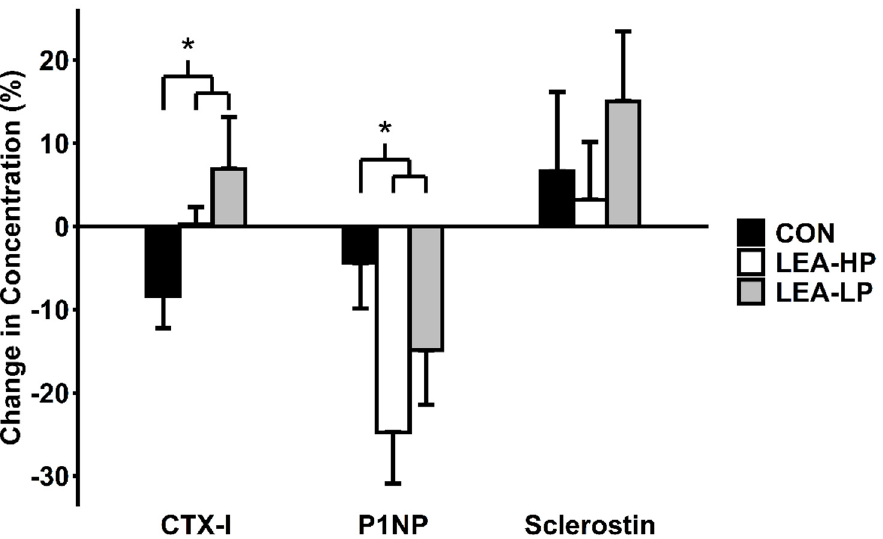
Figure 3. Changes in markers of bone turnover by condition. Abbreviations: CTX-I, type I collagen cross-linked C-telopeptide; P1NP, procollagen type I N-terminal propeptide; CON, control; LEA- LP, low energy availability with low protein; LEA-HP, low energy availability with high protein. * indicates p < 0.05 LEA vs. CON